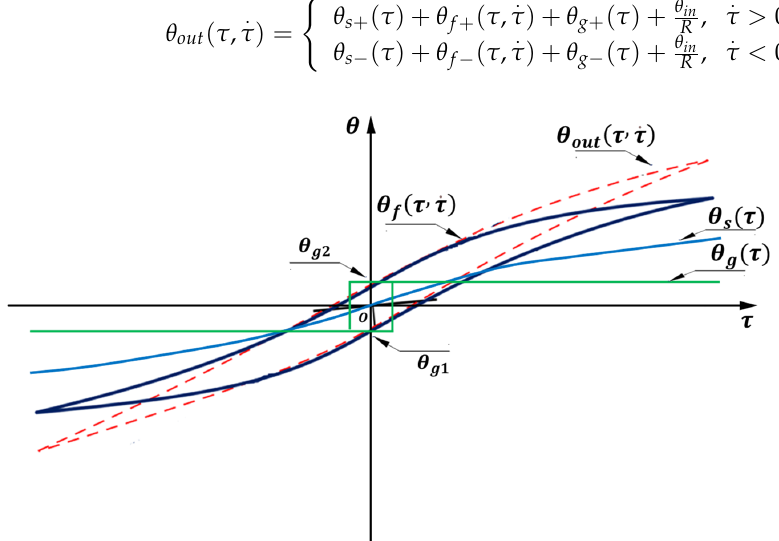
Figure 6. Hysteresis curve function model of reducer. 𝜃 (cid:4666)𝜏 , 𝜏(cid:4662)(cid:4667) reflects that the hysteresis phenomenon of the reducer is related to the mag ‐ (cid:3042)(cid:3048)(cid:3047) nitude of the loaded torque. It is also related to its change rate. This means that the loading rate will also lead to a change in the hysteresis characteristics of the reducer.